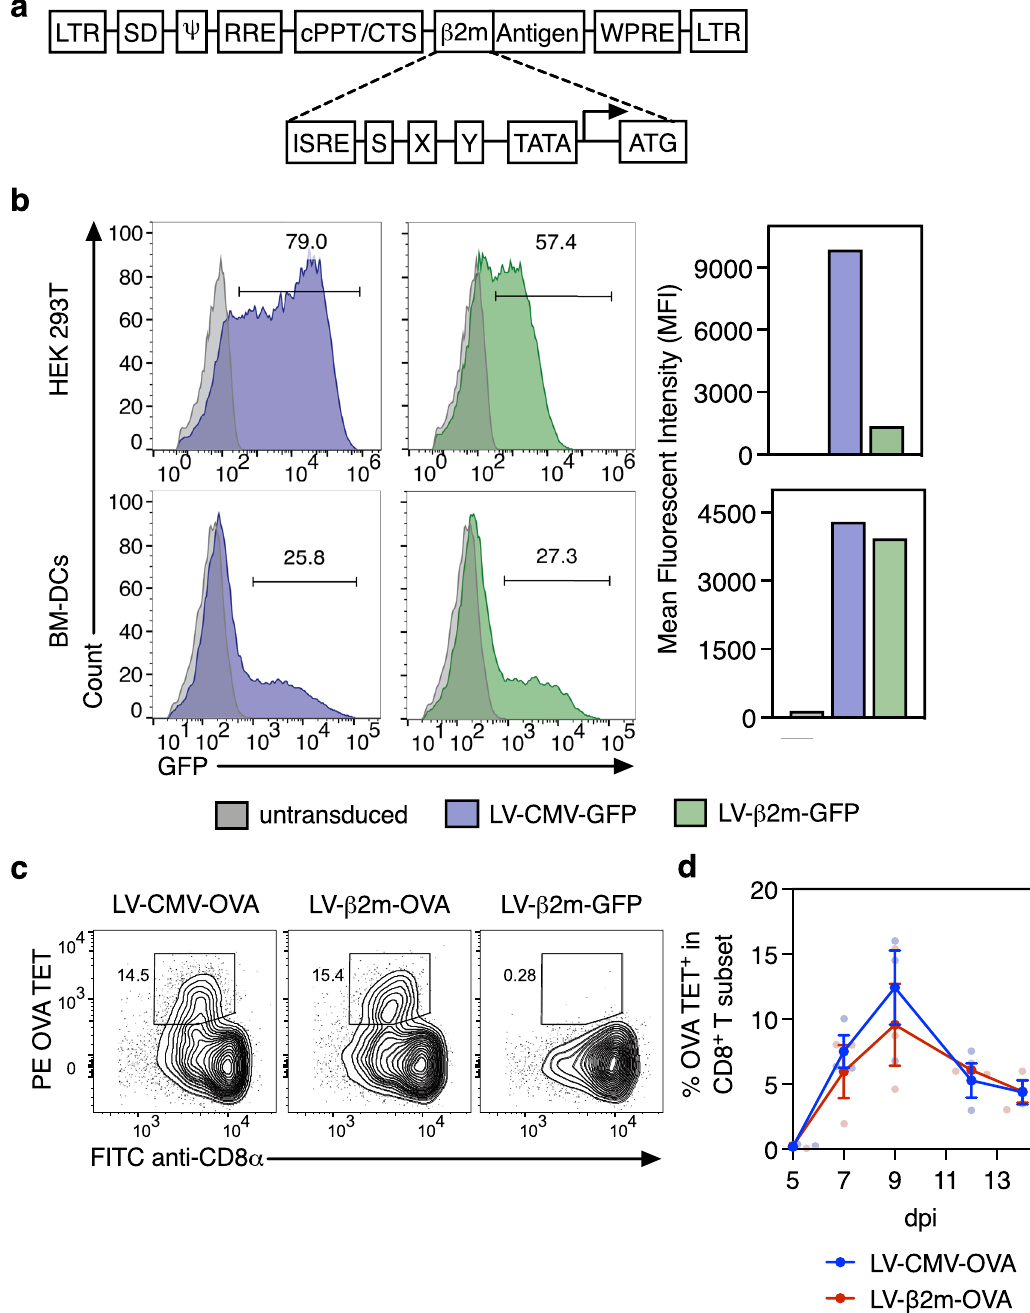
Fig. 1 Comparison of CMV and β 2m promoter in terms of cell transduction ef fi ciency and in vivo CD8 + T-cell induction. a Schematic representation of the segment of the transfer plasmid, containing β 2m internal promoter, used in the lentiviral vector. LTR long terminal repeats; SD, Shine – Dalgarno sequence; RRE, rev response element; cPPT, central polypurine tract; CTS, central termination sequence; ISRE, interferon-stimulated response element; WPRE, woodchuck hepatitis virus posttranscriptional regulatory element. b HEK 293T and bone marrow-derived dendritic cells from C57BL/6 mice were transduced with LV-CMV-GFP (blue) or LV- β 2m-GFP (green) at MOI 10 for 3 days. Percentage of GFP + cells (left) and mean fl uorescent intensity (right) of GFP + cells were compared by fl ow cytometry. c C57BL/6 mice ( n = 3/group) were immunized i.m. with 5 × 10 7 TU of LV-CMV or LV- β 2m encoding for immunized mice used as negative controls. d The frequencies of OVA-speci fi c CD8 + T cells in the blood determined by cytometry at 5, 7, 9, 12, and 14 dpi, expressed as mean ± SEM. Smaller dots represent biological